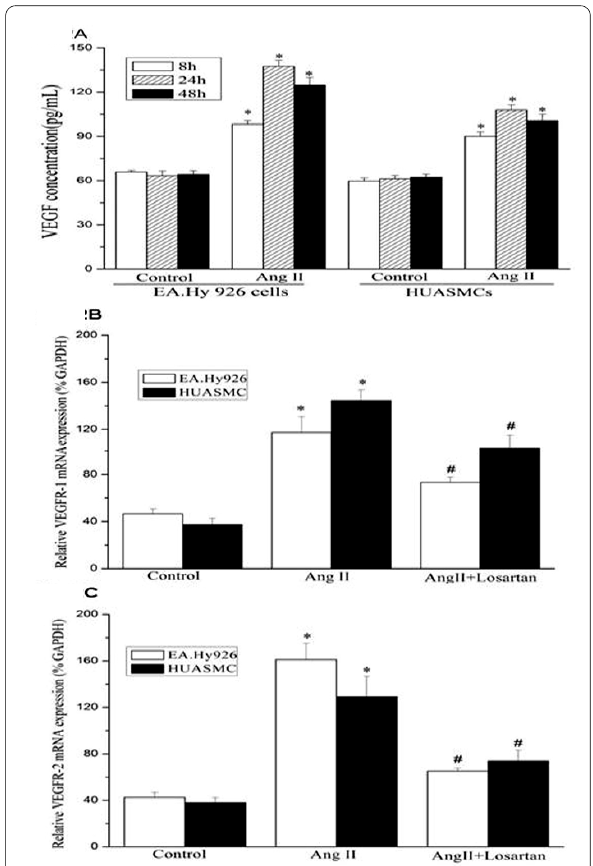
Figure 2 Angiotensin II increases VEGF release (A) and VEGFR-1 and -2 mRNA expressions (B, C) in EA.Hy 926 endothelial cells and HUASMCs. (A) Release of VEGF in the cell culture media measured by ELISA. Growth-arrested cells were incubated with Ang II (10 -7 , 10 -6 and 10 -5 mol/L) for 8 hrs, 24 hrsor 48 hrs, and VEGF protein released into cell culture media was measured by ELISA (n = 3 in each group). * indicates P < 0.05 vs control EA.Hy 926 cells or HUASMCs. (B) Real-time PCR re- sults: Ang II induced VEGFR-1 mRNA expression in both EA.Hy 926 en- dothelial cells and HUASMCs. * indicates P < 0.05 vs control EA.Hy 926 cells or HUASMCs. # indicates P < 0.05 vs cells treated with Ang II. (C) Real-time PCR results: Ang II induced VEGFR-2 mRNA expression in both EA.Hy 926 endothelial cells and HUASMCs. * indicates P < 0.05 vs control EA.Hy 926 cells or HUASMCs. # indicates P < 0.05 vs cells treated with Ang II.